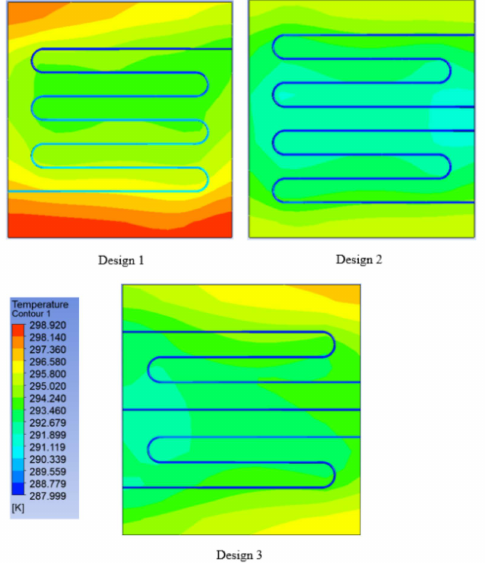
Figure 9. Temperature contours for the three different flow configurations.